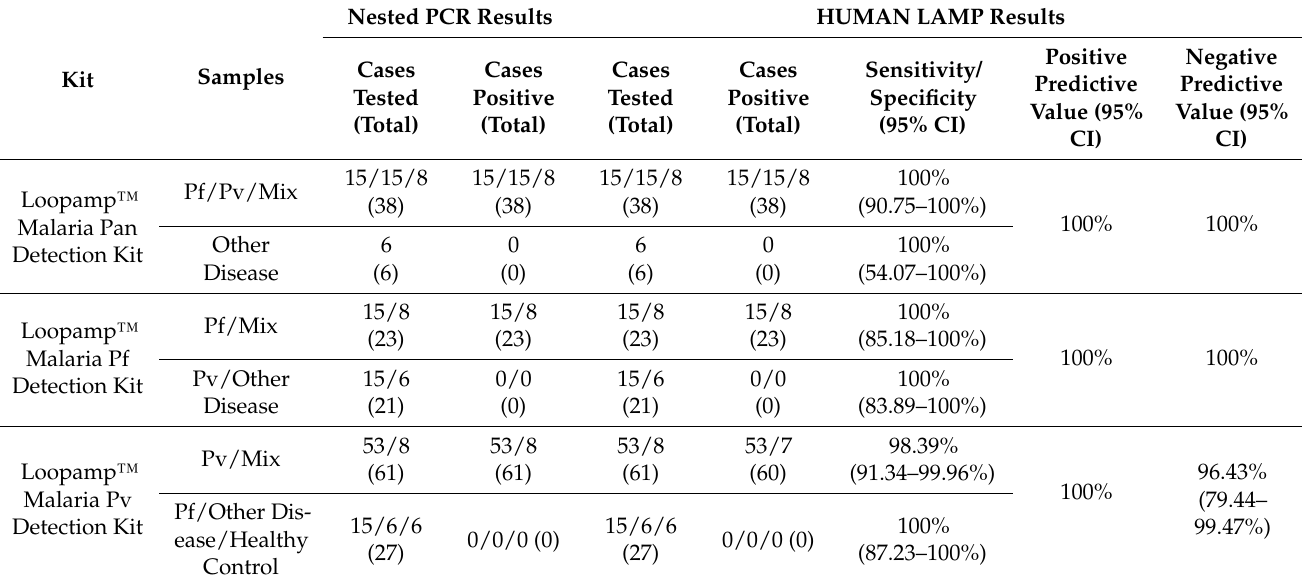
Table 3. Diagnostic performance parameters of Loopamp TM Malaria (Pan/Pf/Pv) Detection